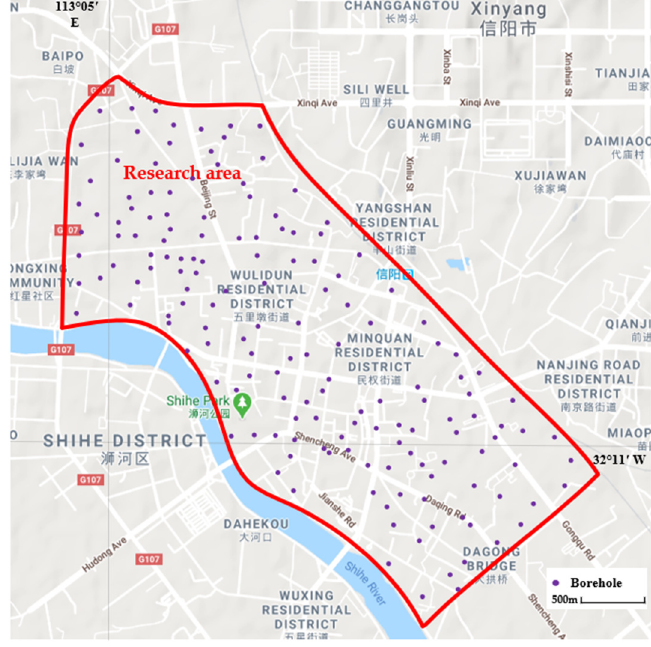
Figure 11. Geological research area in Xinyang City.